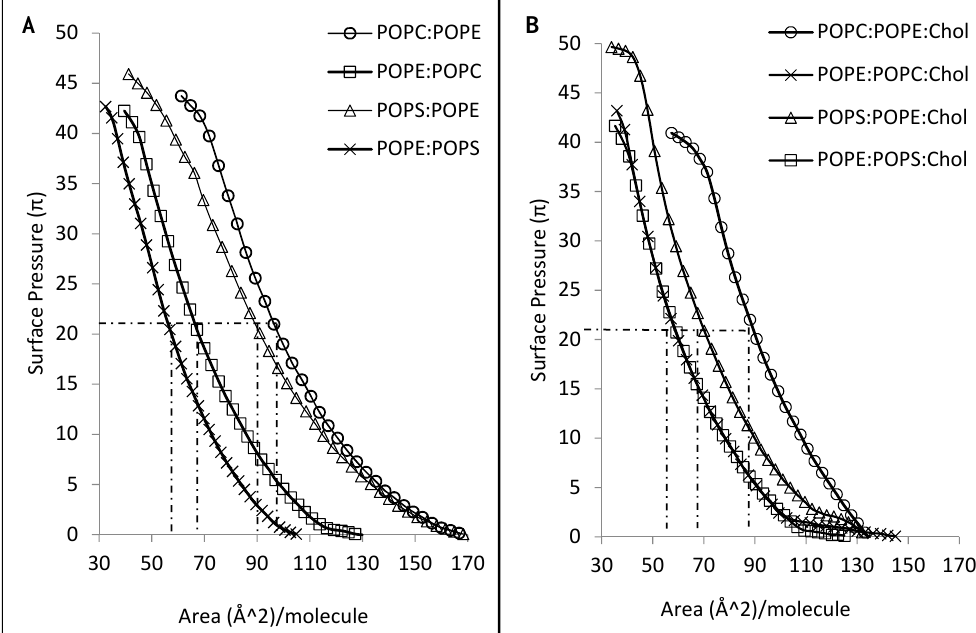
Figure 5. (A) Surface pressure ‐ area isotherms of different lipid mixtures of 5:1 mole ratio (B) Surface pressure ‐ area isotherms of the same lipid mixtures containing cholesterol in a 4:1:1 mole ratio measured with a Langmuir film balance ( n = 3).